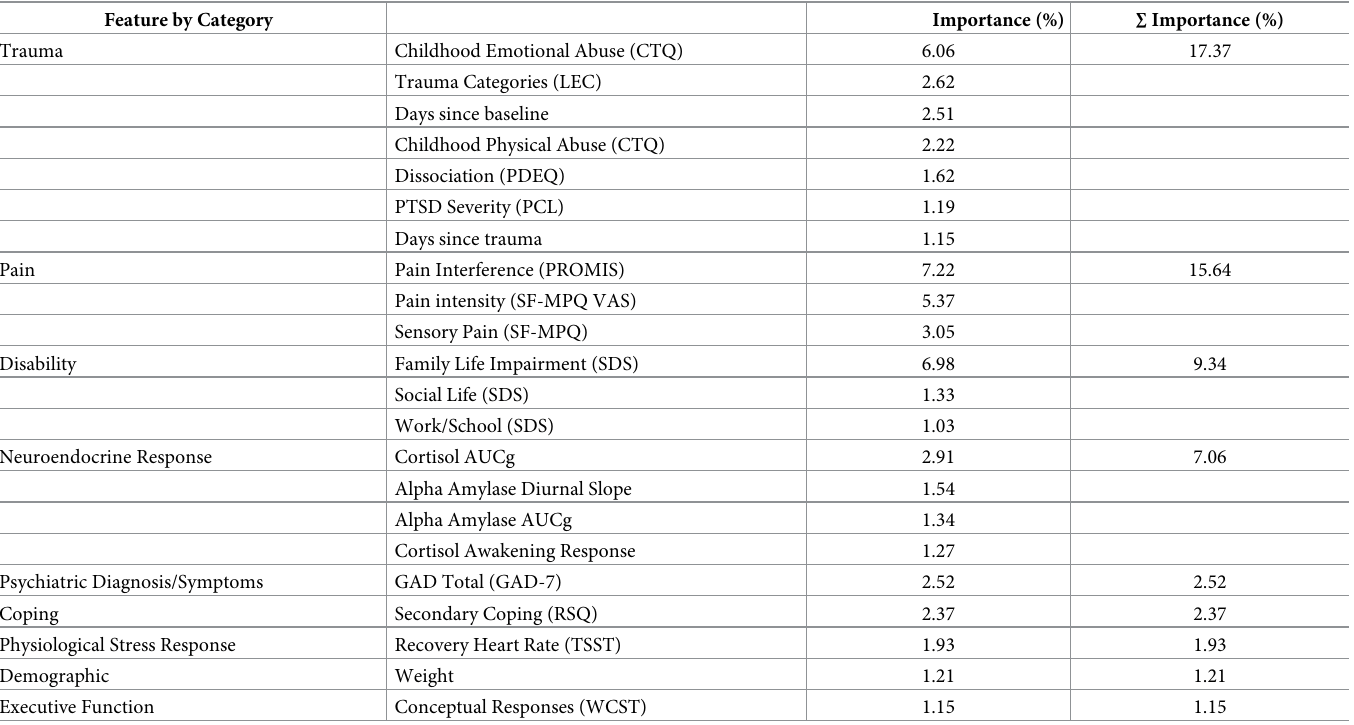
Table 2. Relevant features ( > 1% importance) in gradient boosting machine models predicting pain interference. Feature by